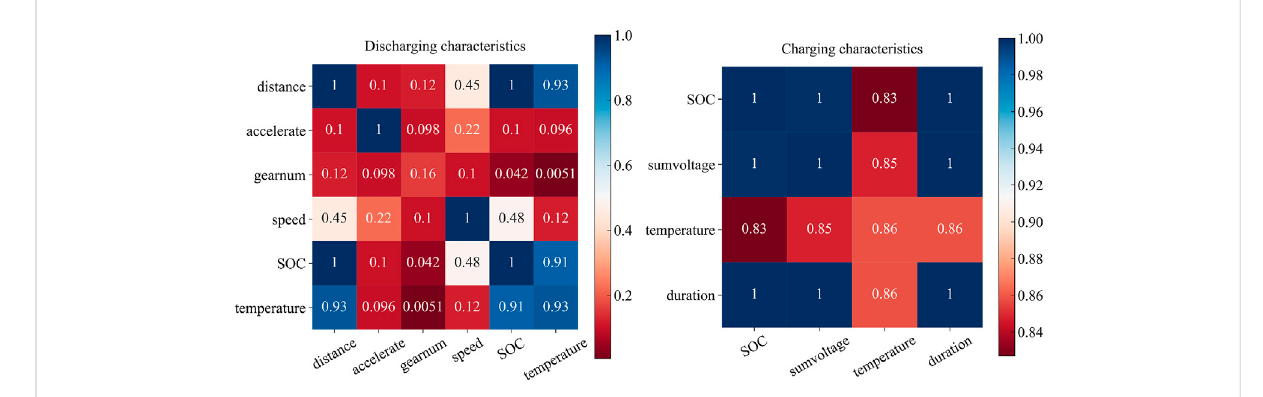
FIGURE 1 MIC matrix analysis of charging characteristics and discharging